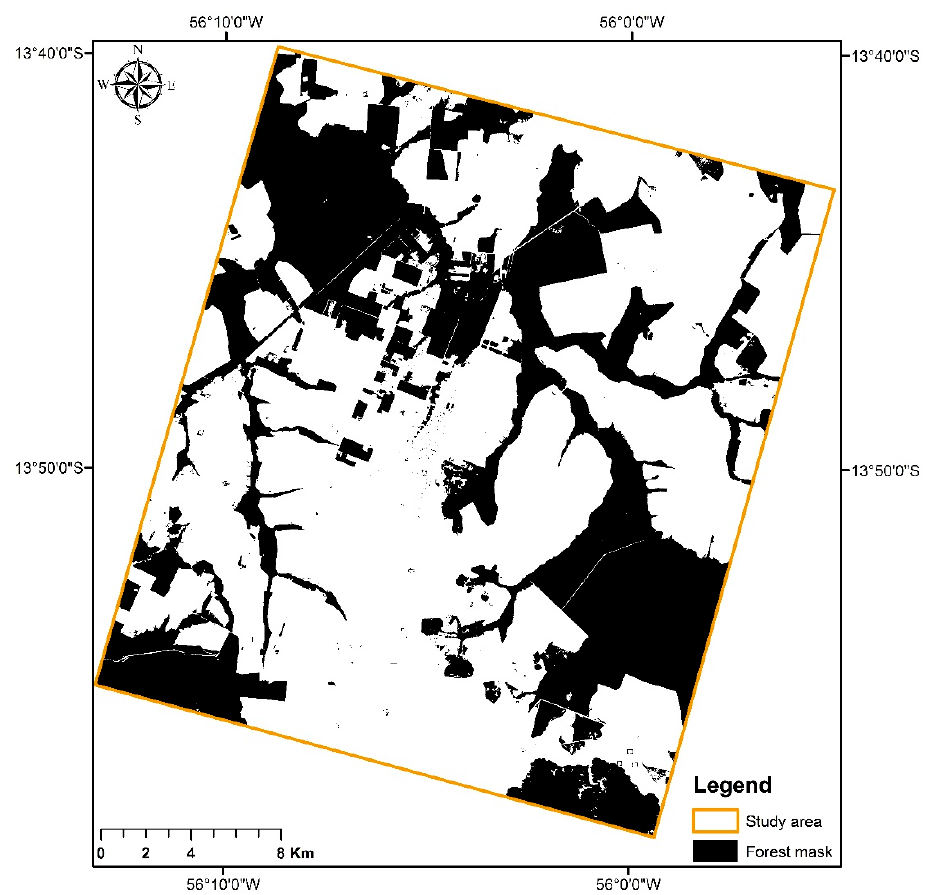
Figure 6. Forest mask extracted from the classification of Sentinel 2A with ALOS-PALSAR full polarimetric PC1 images.